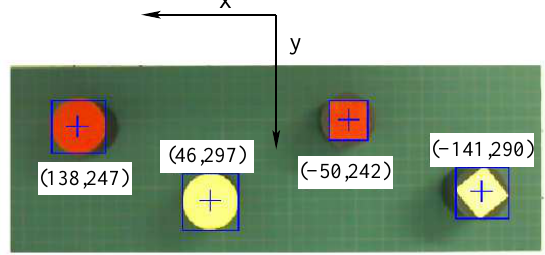
Figure 17. Objects to be collected by the